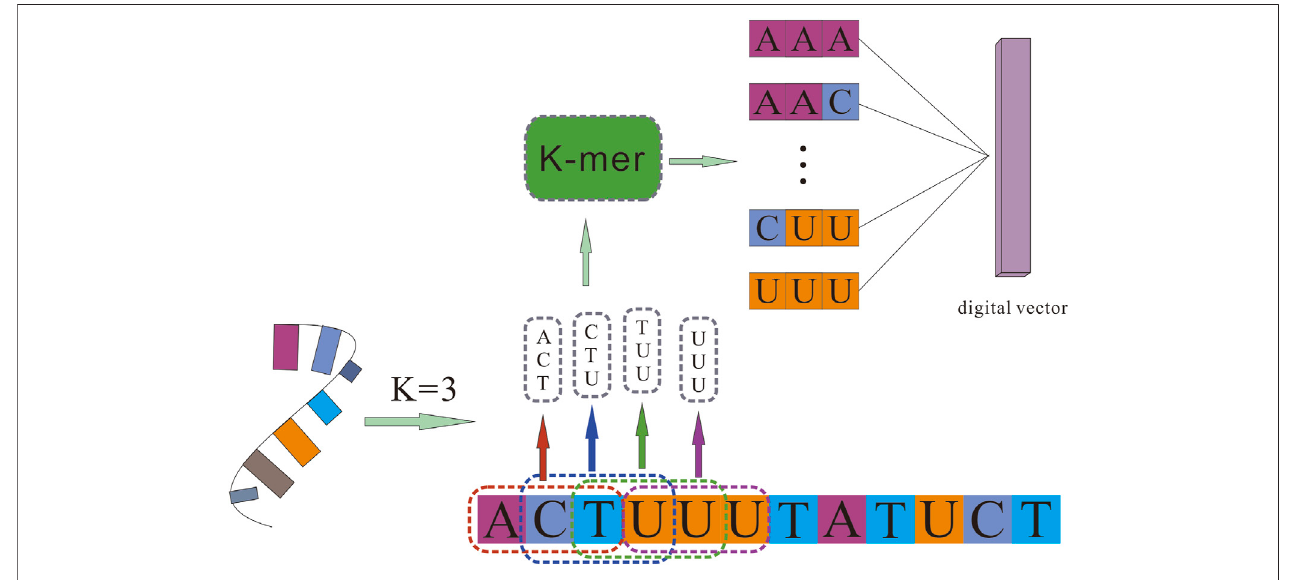
FIGURE 1 | The K-mer algorithm for sequence feature